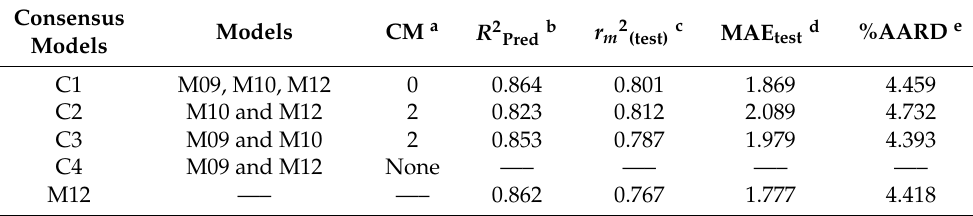
Table 6. External predictivity of the best individual model M12 and consensus models (C1-C4) built with different combinations of the top three models (M09, M10 and